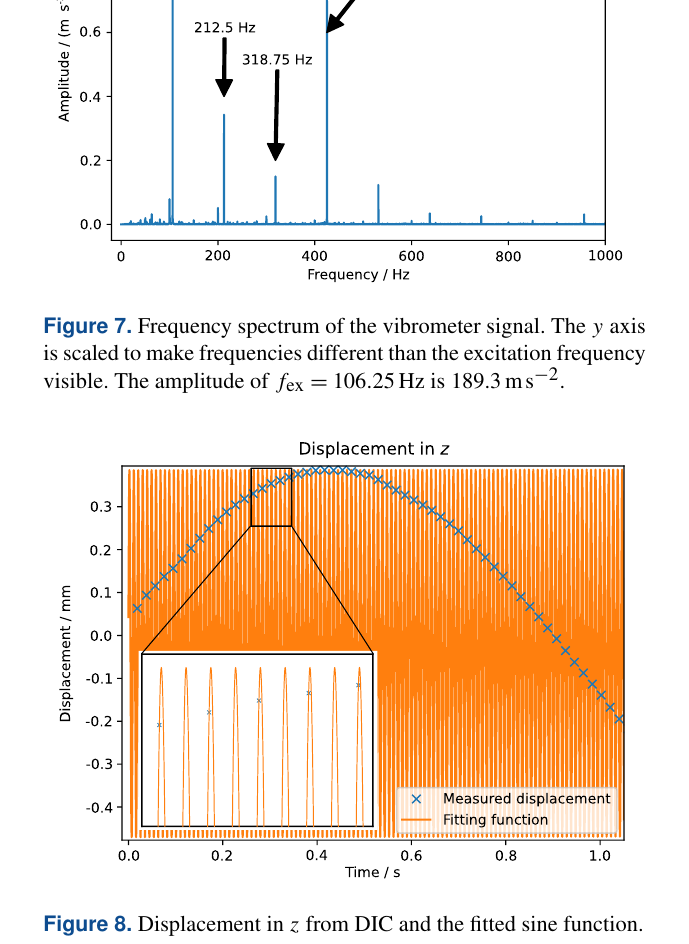
ial and angular displacement along the x axis. The resulting parameters from the sine fitting are listed in Table 1.